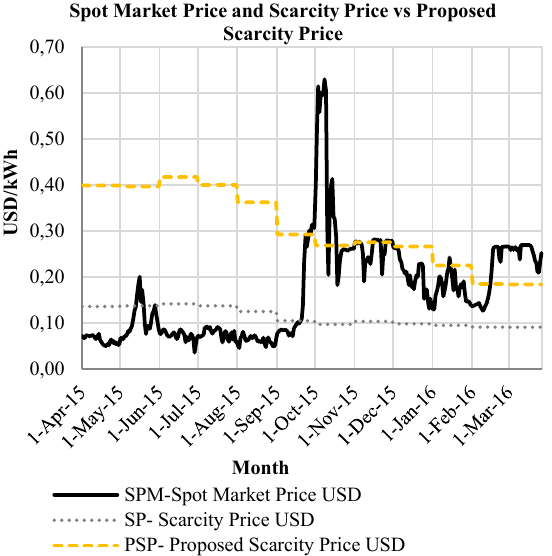
Fig. 2. Proposal for a new definition of the SP: Case Study. Note: The Scarcity prices were converted into USD using the same ECR of SP tf